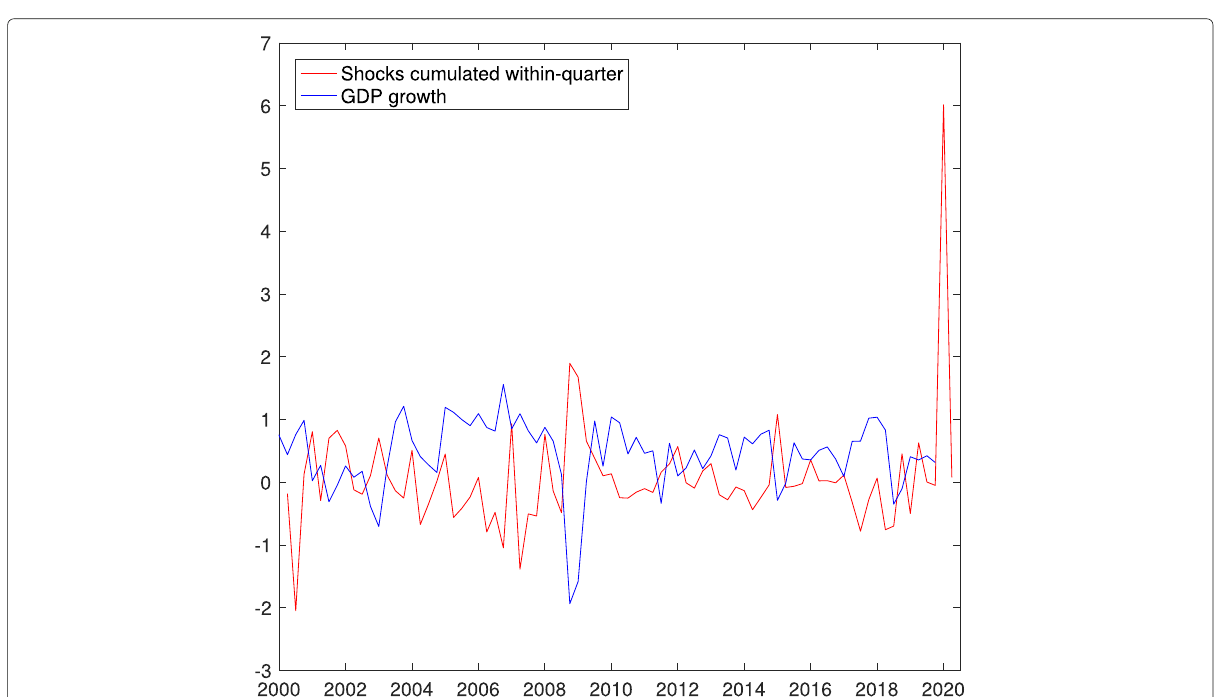
Fig. 6 GDP growth and within-quarter cumulated shocks in log short-time workers. Sample period: Second quarter 2000–fourth quarter